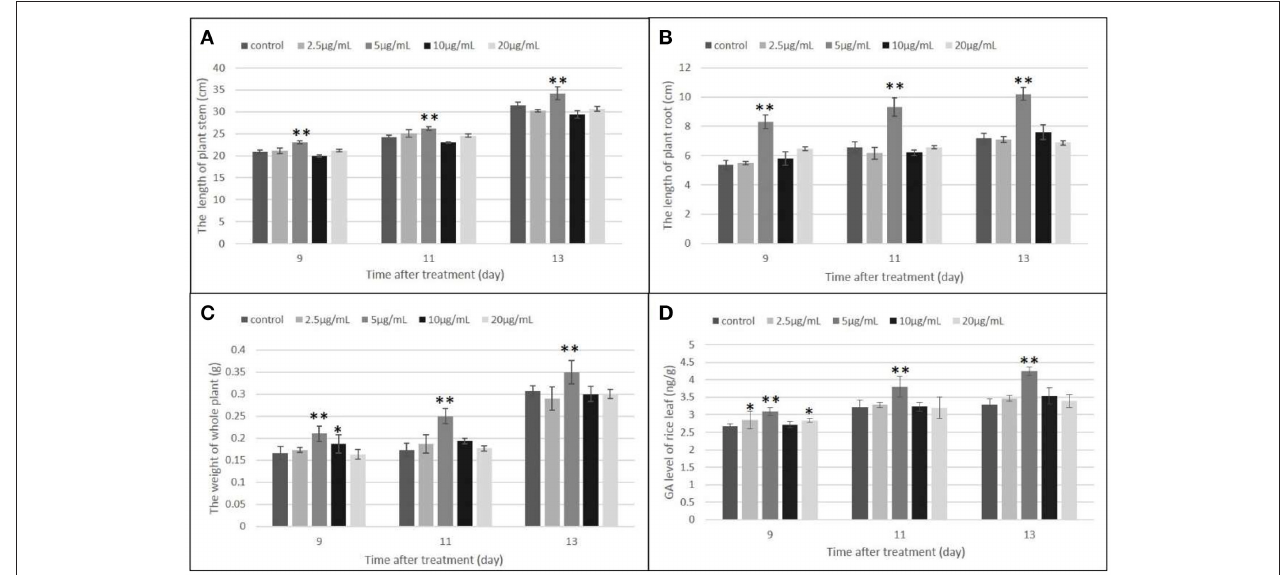
FIGURE 7 | Growth promotion and GA level of plant seeds treated with a range of concentrations of MoHrip1. (A) Average length of the plant stem. (B) Average length of the plant root. (C) Average weight of the whole plant. (D) GA levels of plants under different treatment conditions. Values are presented as the mean ± SD of three replicates, each consisting of 15 seedlings. Asterisks indicate statistically significant differences, as measured using SAS software (Duncan’s t test, ** p < 0.01, * p < 0.05).